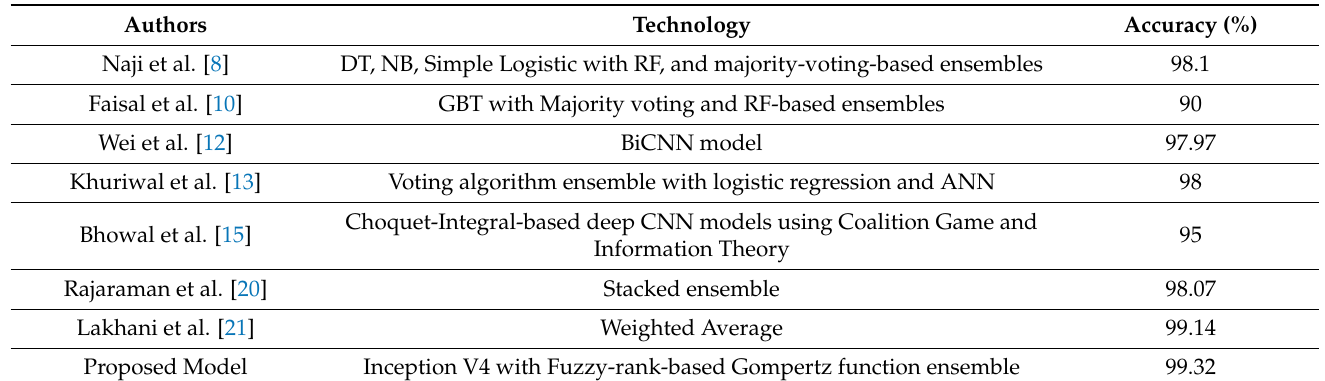
Table 2. Comparison of the performance of several deep CNN models with the suggested breast cancer detection